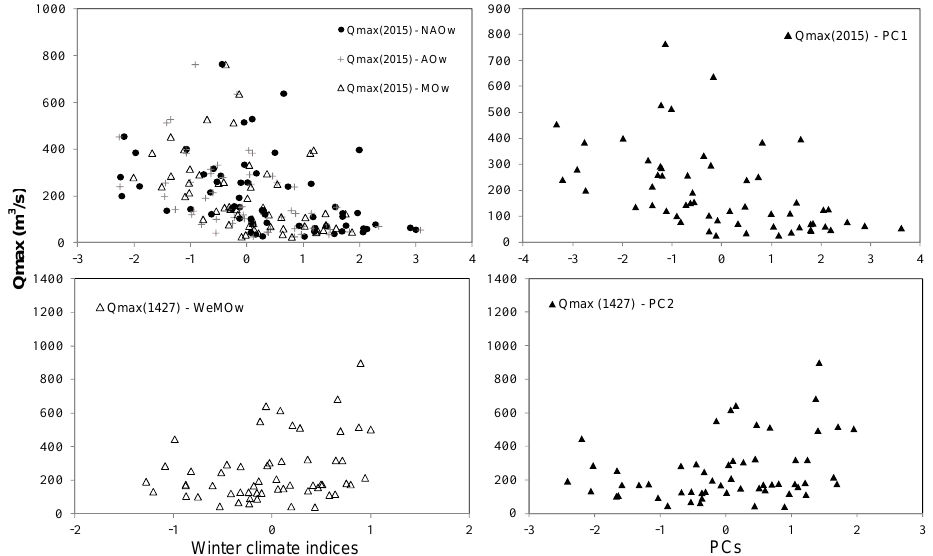
Fig. 3. Scatterplots between annual maximum peak discharge and the corresponding values of the principal components (right panel) and winter climatic indices (December to February) (left panel) in two representative flow gauge stations: upper panel with low altered regime and lower panel with natural regime.